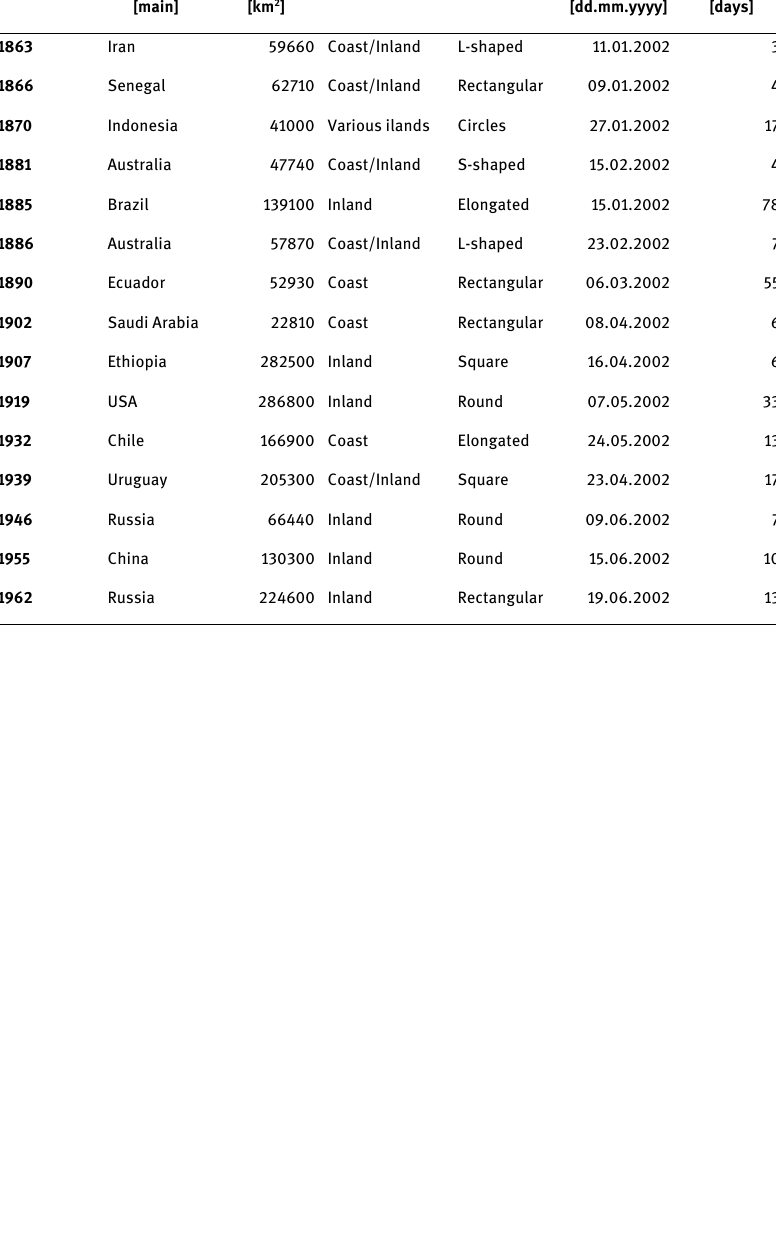
Table 3. Analysed floods selected from the DFO archive. The ID (*) is taken from the archive.